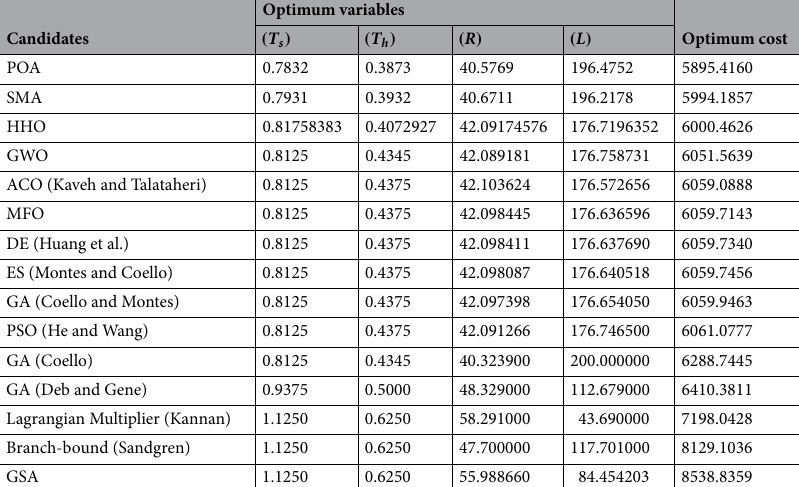
Table 15. Comparison of results for pressure vessel design